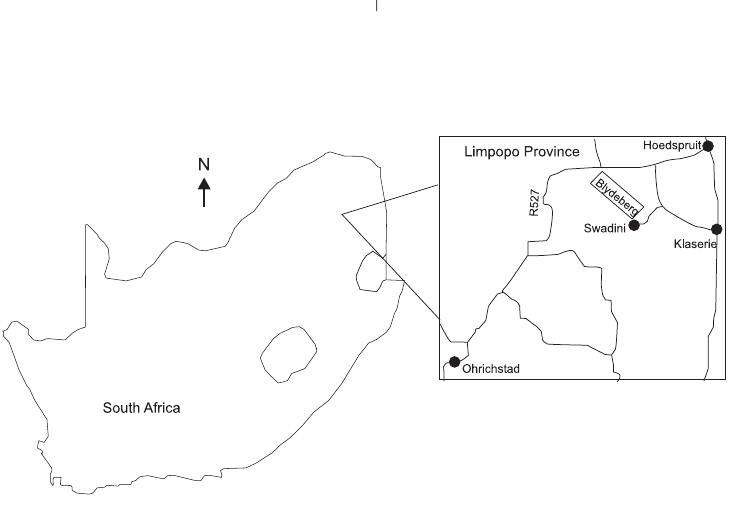
Fig. 1. Location of Blydeberg Conservancy within the Limpopo Province of South